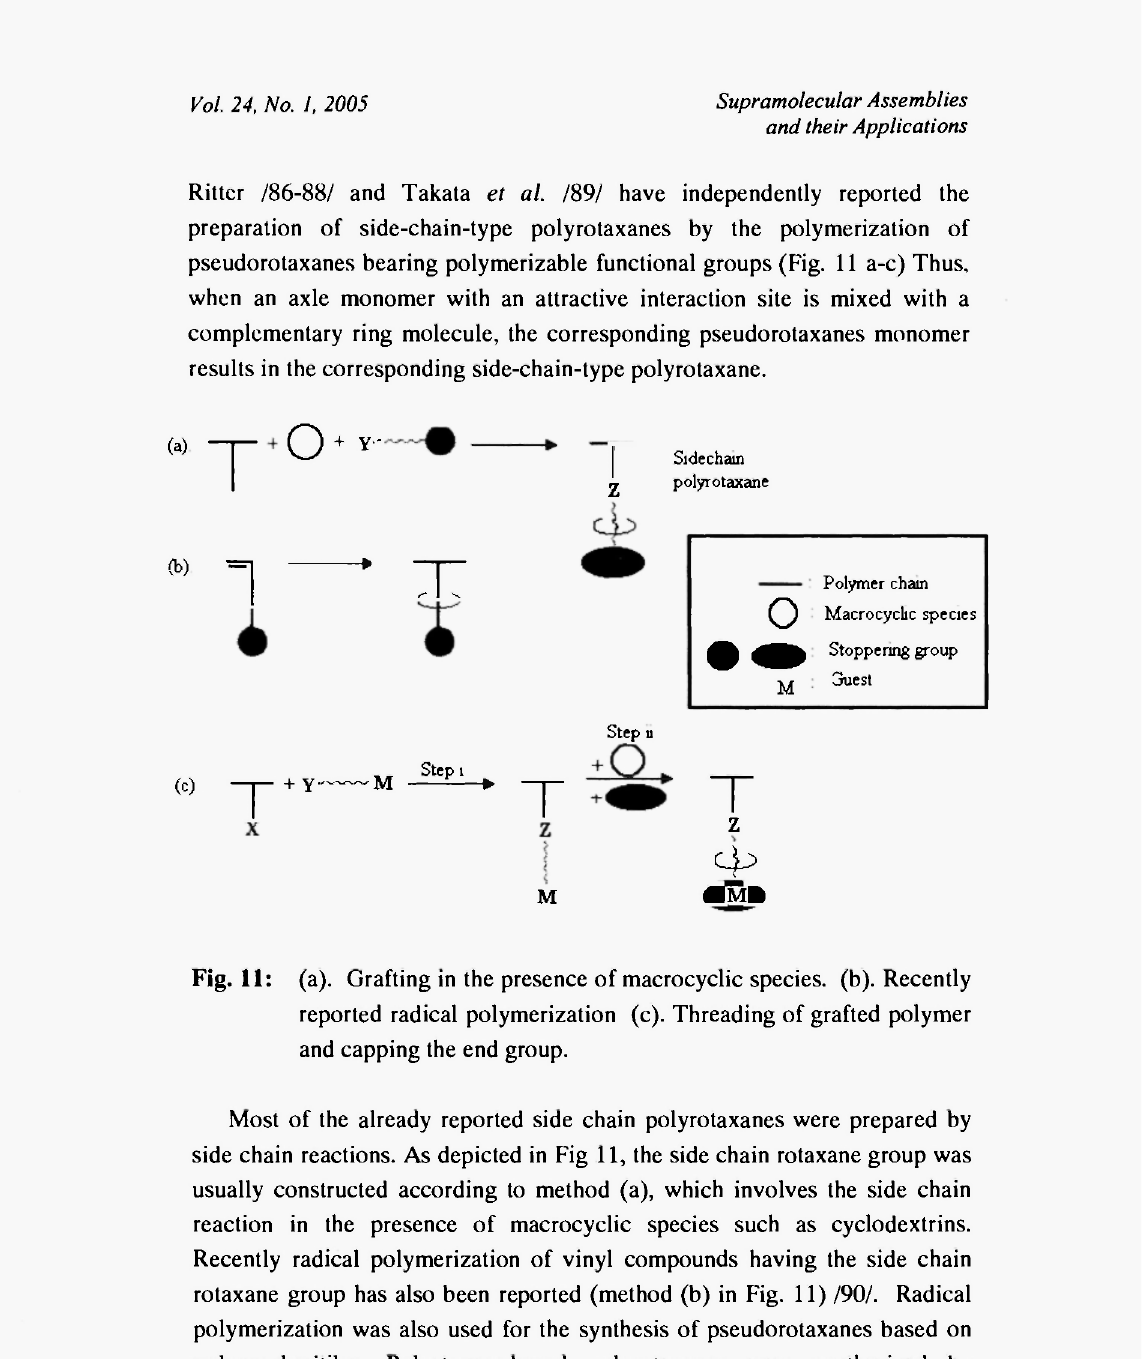
(a). Grafting in the presence of macrocyclic species, (b). Recently reported radical polymerization (c). Threading of grafted polymer and capping the end